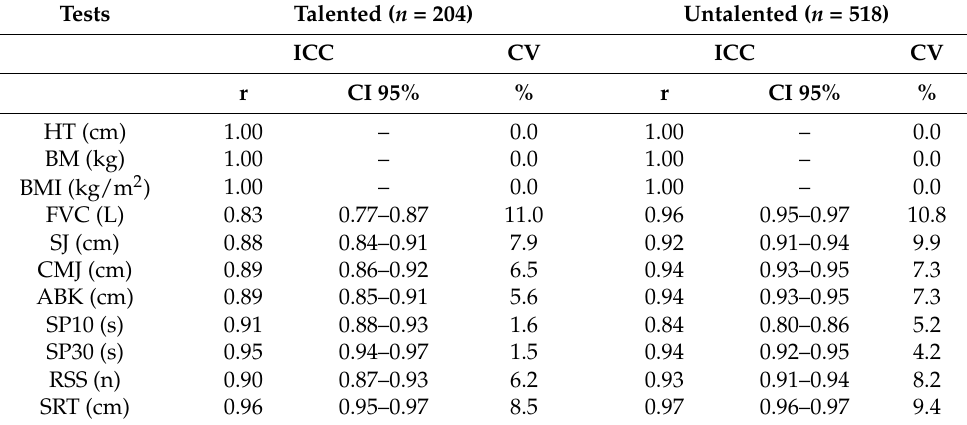
Table 1. Test–retest reliability statistics for 722 children, talented and untalented Chinese soccer players.